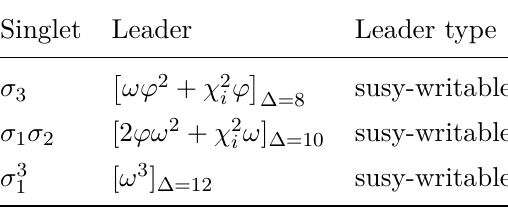
Table 3 . Scalar leaders with N φ = 3 , N der = 0 in d = 8 .